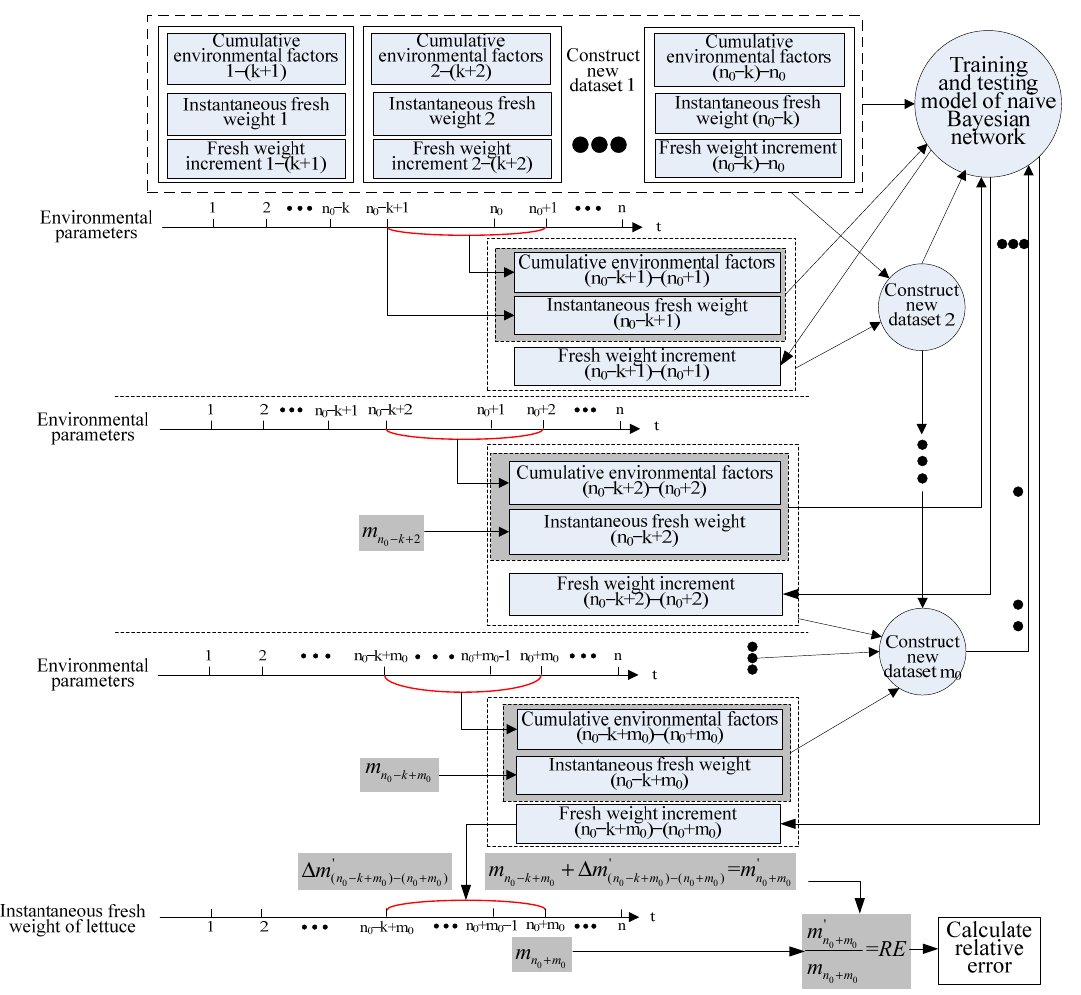
Figure 4. Schematic diagram of the solution process for predicting fresh weight in the next m 0 days based on the phenotypic and environmental data from the previous k days.